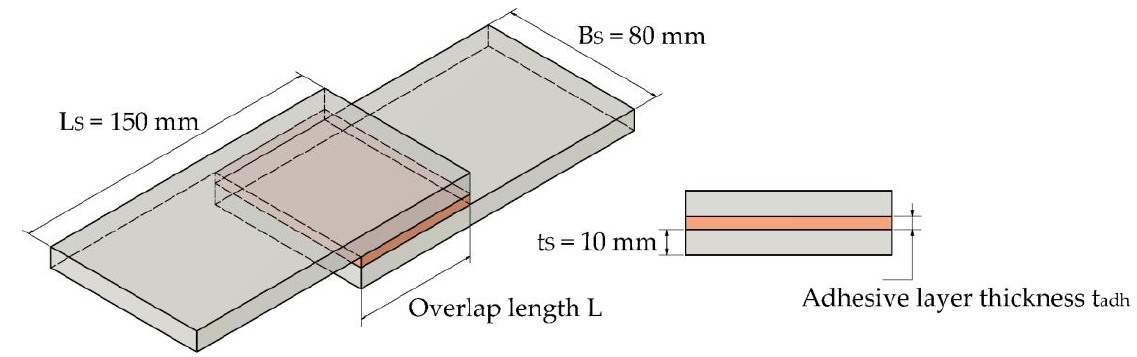
Figure 1. Schematic representation of the overlap joint showing relevant geometric dimensions of the substrates and the adhesive layer in accordance with [22].